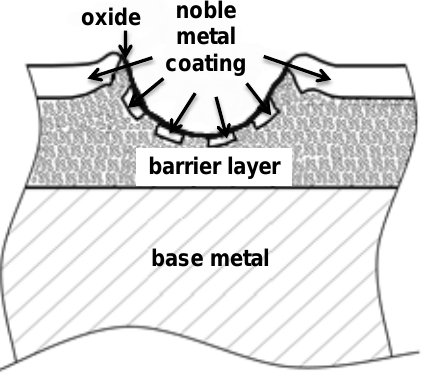
Figure 5. Wear pattern III—partial wear out of the final coating and contact surface totally covered with